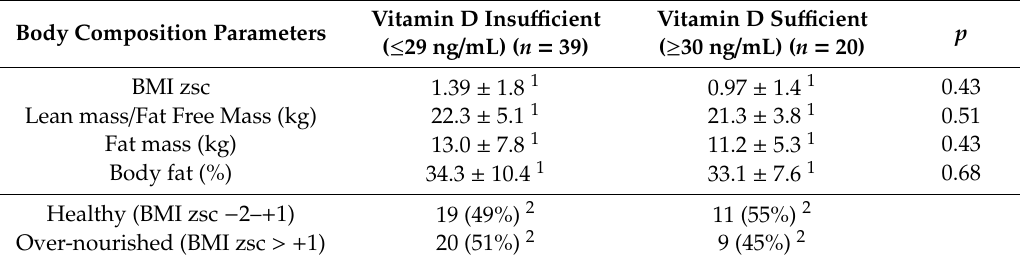
Table 4. Vitamin D status in relation to body composition parameters ( n =